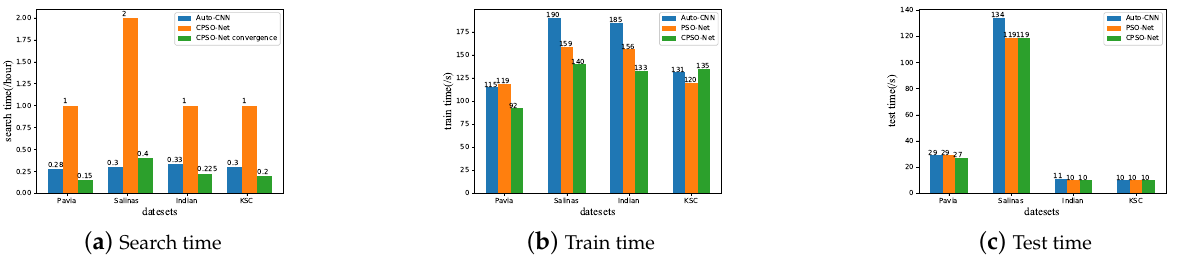
Figure 7. Time consumed in the different stages of the different automatically designed CNNs methods based on four biased HSI